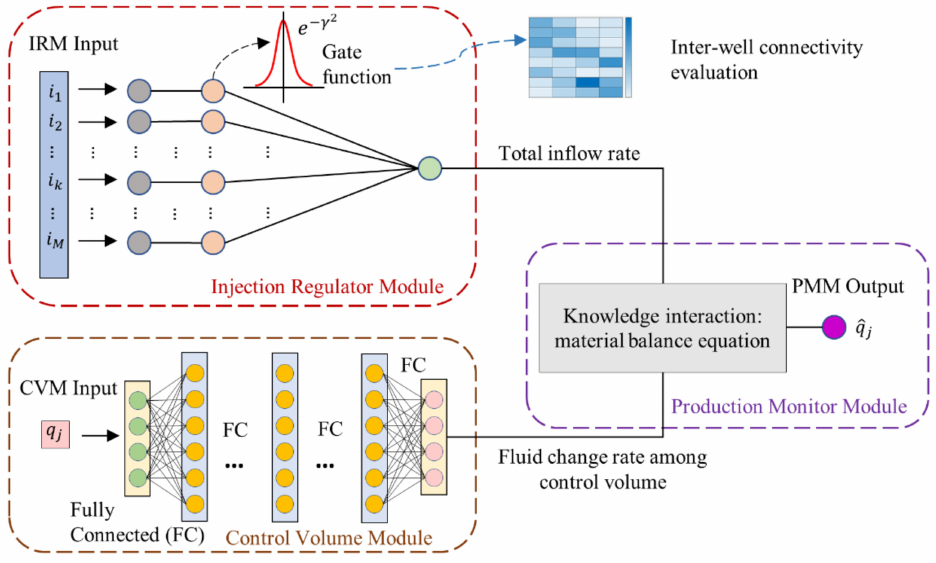
Figure 1. The architecture of